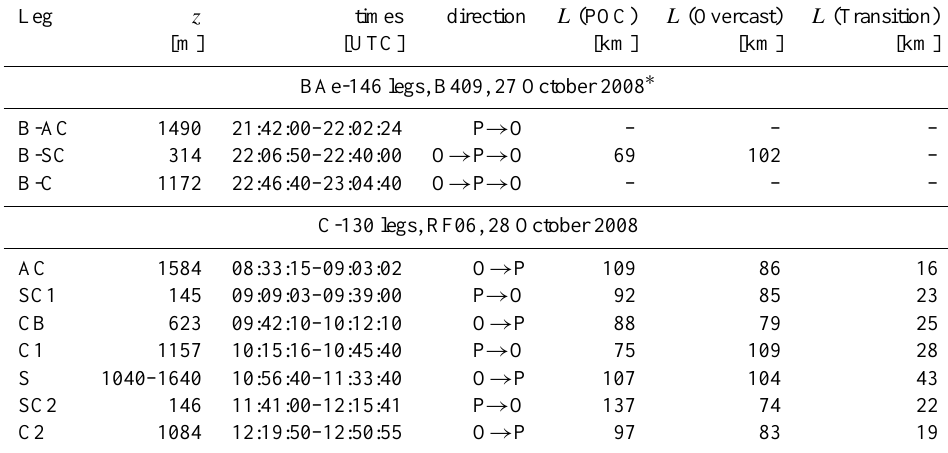
Table 1. Overview of C-130 flight legs, and the earlier BAe-146 flight legs. SC: subcloud leg; CB: leg around cumulus cloud base level; C: leg near the center of the stratocumulus cloud layer; AC: above cloud leg in the free-troposphere above the marine inversion; S: sawtooth run from above inversion to base of cloud. The mean run altitude z is given. Directions are given as from POC to overcast (P → O) or vice-versa. Times are in UTC (LT + 5h). Run lengths L in the three different regions are given in kilometers. Leg z times direction L (POC) L (Overcast) L